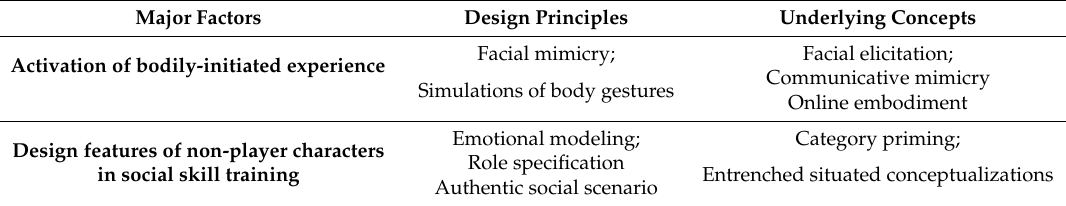
Table 1. Design factors to simulate a VR-based social skill